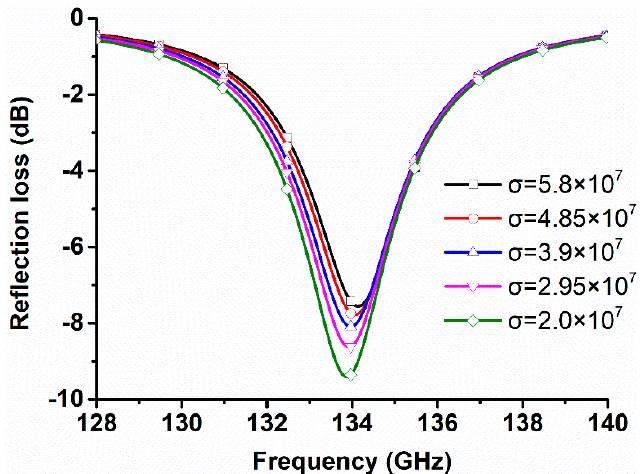
Figure 2. Simulated effect of conductor losses on the reflection loss of the phase shifter.